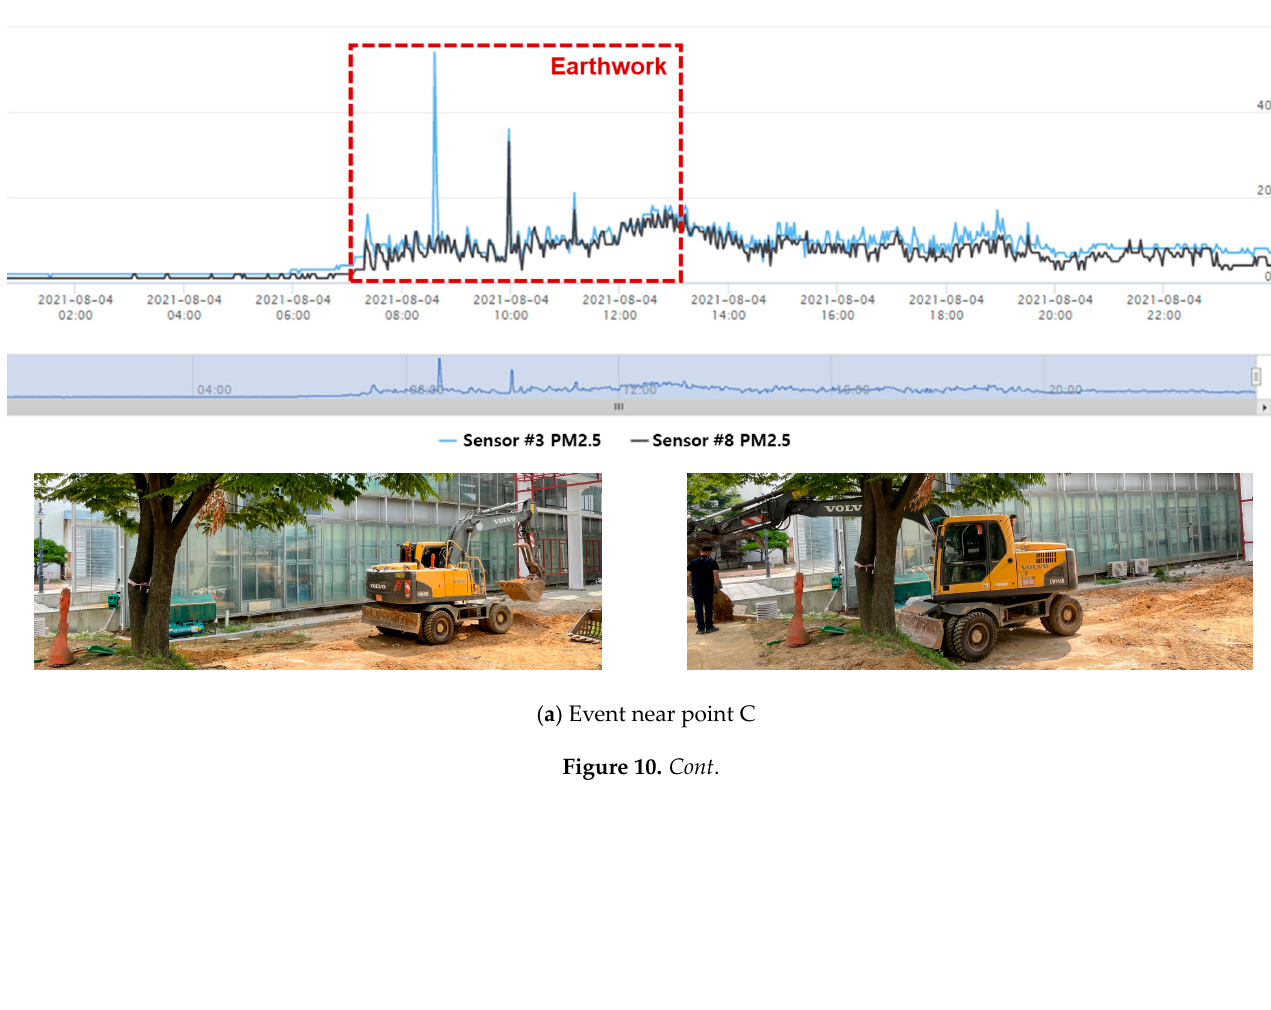
Figure 9. PM2.5 concentration chart (2 August~6 August).